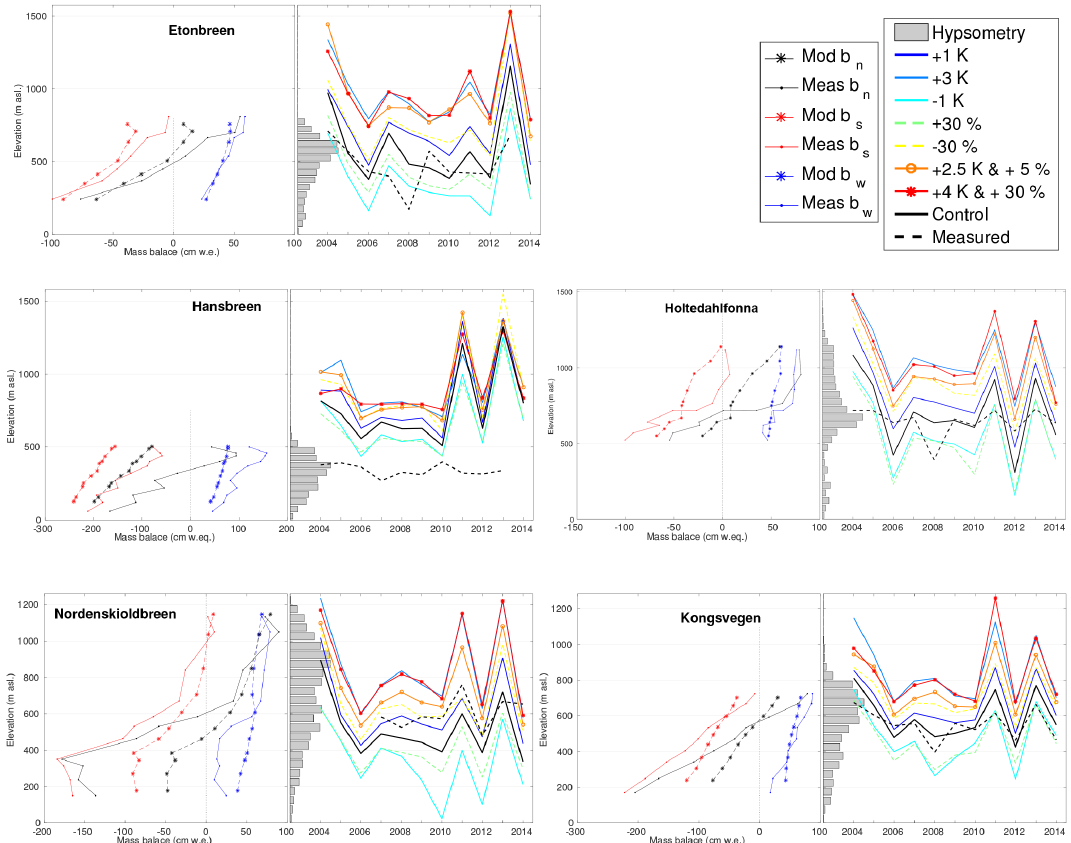
Figure 11. Modelled and measured seasonal mass balance gradients (left panels of each glacier’s subplot) at the five validation glaciers averaged over the period 2004–2013 (right panels). Modelled results include the control run and sensitivity experiments. Dots and stars mark the altitudes of the measurement sites and corresponding DEM grid cells respectively. Grey bars show area-altitude distribution for 50m elevation bins. Note that the mass balance measurements at Kongsvegen, Etonbreen and Hansbreen over 2004–2013 also are used for model